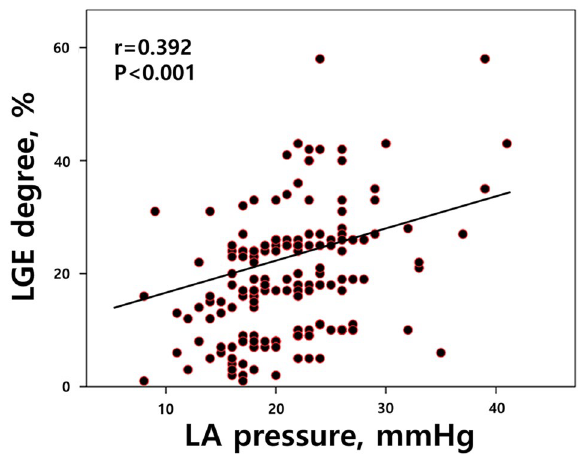
Figure 2. The relationship between measured left atrial pressure and late gadolinium enhancement (LGE) extent in cardiac magnetic resonance. Each point on the plots represents a value of the LGE extent in one patient. R and P represent Pearson’s correlation coefficients and the corresponding P-values. LA left atrial, LGE late gadolinium enhancement, LA pressure left atrial pressure.